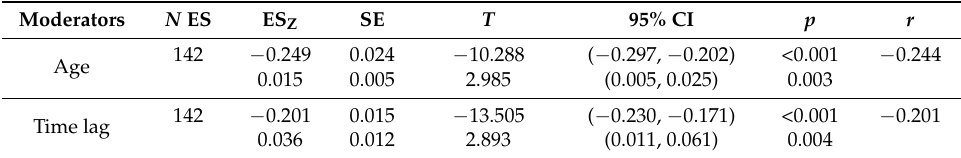
Table 3. Univariate analyses presenting slopes of the significant